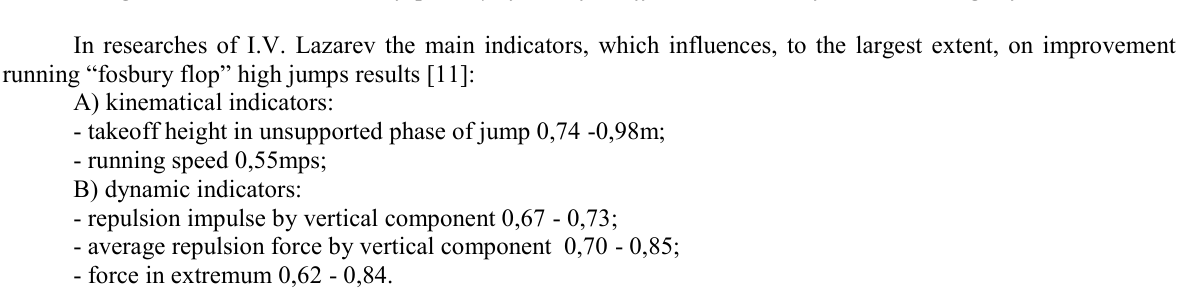
Fig 6. Characteristic curves of quantity of turns for different moments of inertia relating to front